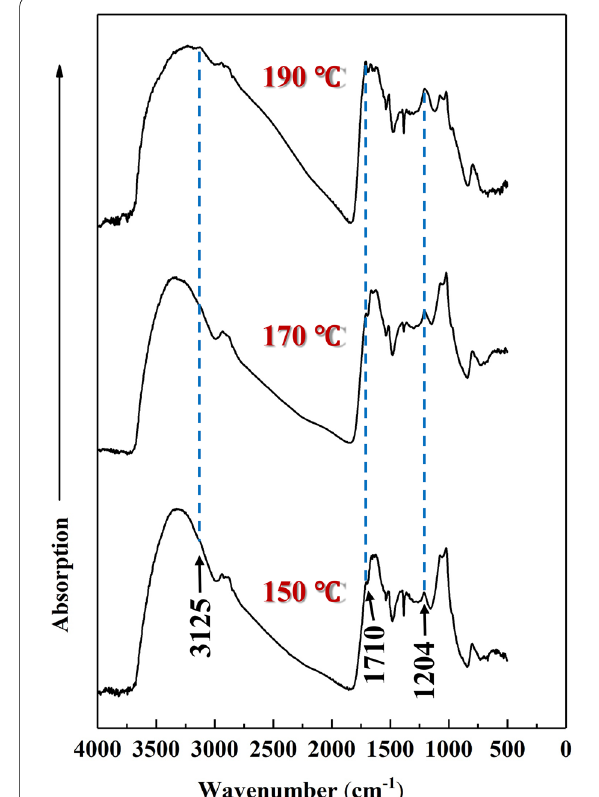
Fig. 8 FT-IR spectra of the plywood bond interface obtained from different hot pressing temperature